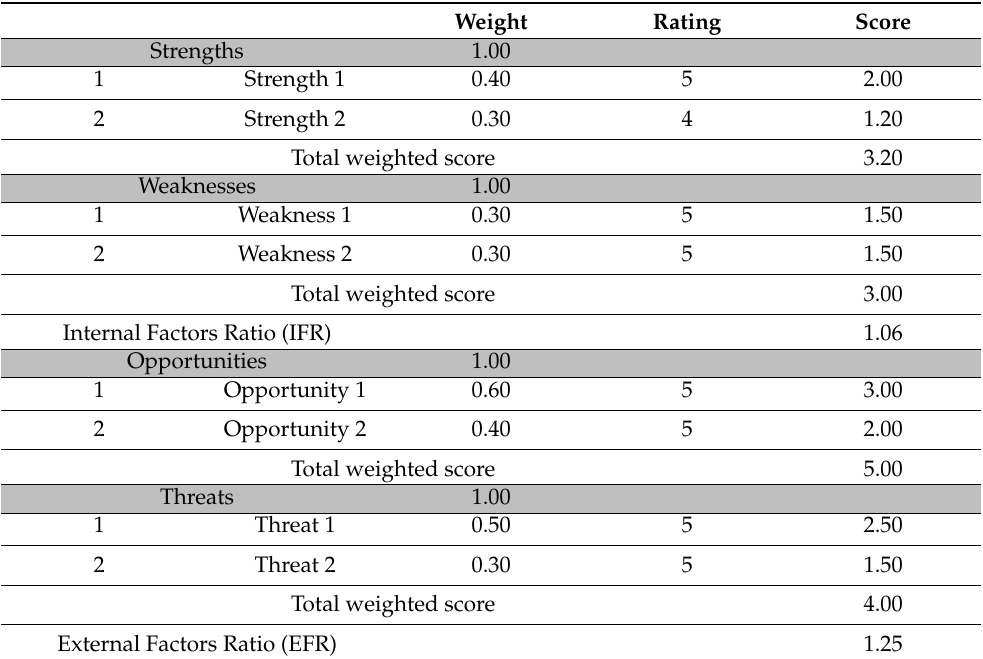
Table 1. The example of the Weighted SWOT